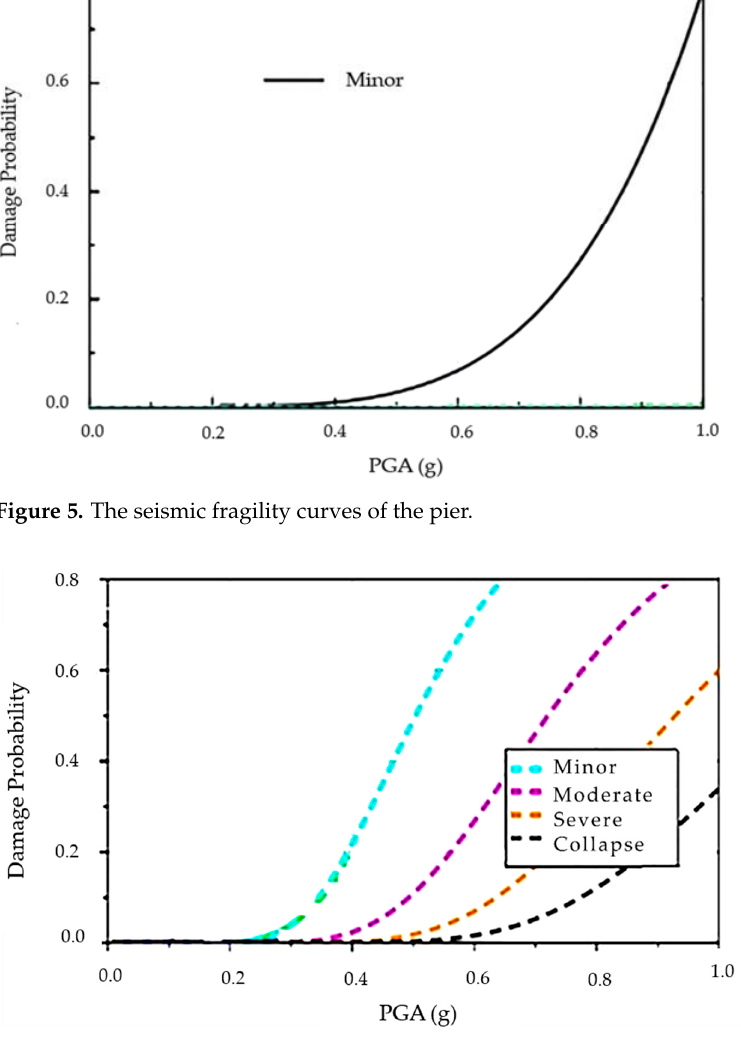
Figure 6. The seismic fragility curves of the isolated bearing.